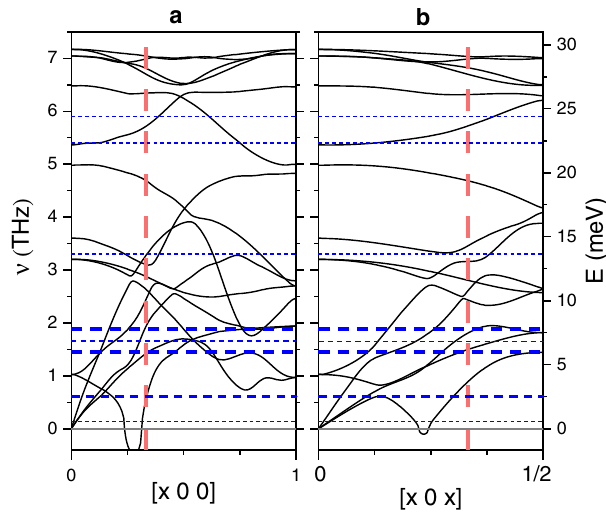
Fig. 3 Phonon dispersion calculation of the high-temperature tetragonal structure. Phonon dispersion along the a [100] and b [101] directions. The dashed red vertical line in a signi fi es the CDW wave-vectors of the incommensurate CDW (I-CDW) while the line in b corresponds to the CDW wave-vectors of the commensurate CDW (C-CDW) order. The dashed horizontal lines indicate the low-temperature frequencies of the observed modes. Note that calculations show an instability in an optical branch quite close to the critical wavevector of the I-CDW (see also